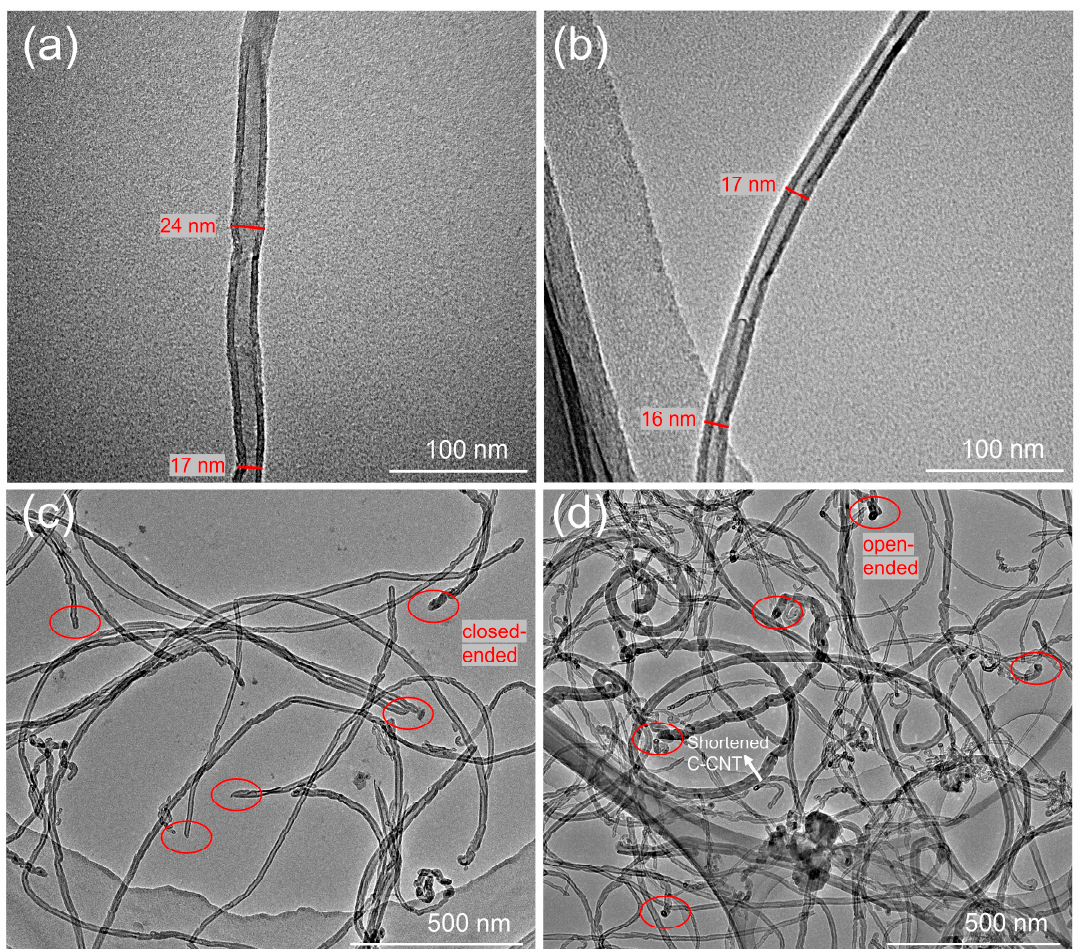
Figure 5. TEM image of ( a ) single CNT, ( b ) single C-CNT, ( c ) CNT with closed ends, ( d ) C-CNT with opened ends.